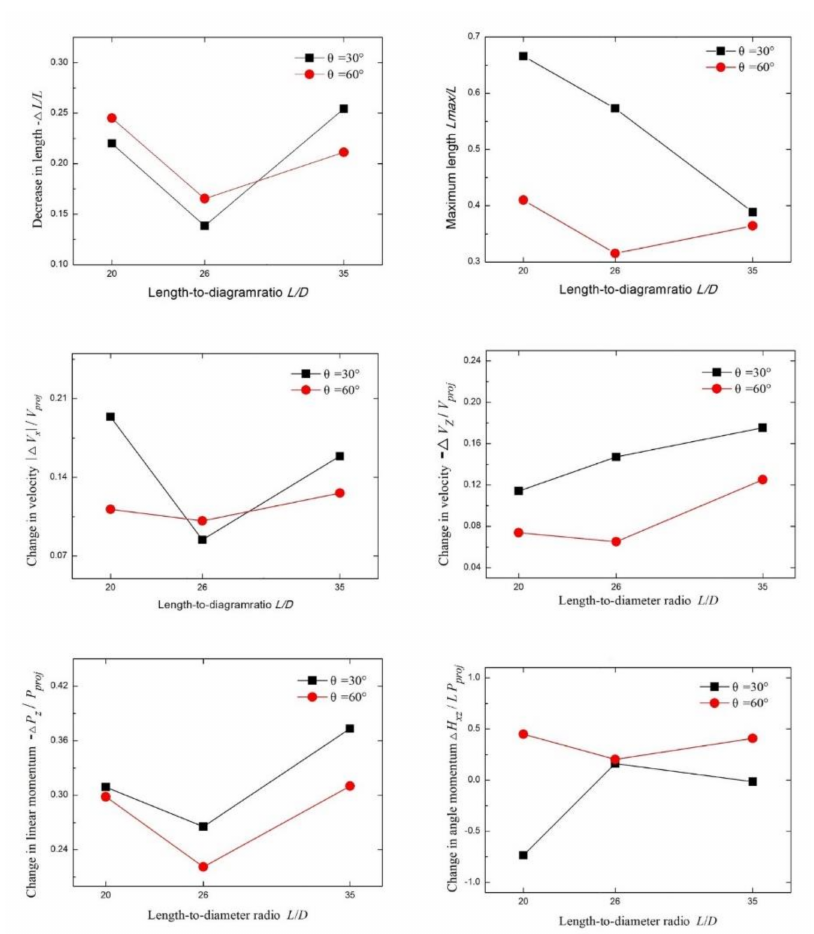
Figure 13. Influence of length to diameter ratio L / D of the long rod at di ff erent inclination angles. V x is the velocity component in the x-axis direction when the fractured rod is deflected by the LEFP. V x depends on the length of the fractured rod and the position of the fractured rod impacted by LEFP. The longer the length of the fractured rod, the larger the inertia and the smaller the V x . The rotation angle of the fractured rod depends on the position of fractured rod impacted by LEFP, implying that the positive and negative values of V x are di ff erent. | ∆ V x | is the absolute value of the velocity change of all fractured rods. The larger the | ∆ V x | value, the greater the longitudinal velocity obtained by all fractured rods. The instability of fractured rods is positively correlated with the angle of the fractured rods from the original penetration direction. It can be seen that when L / D was 20 and 35, | ∆ V x |/ V proj was greater than that of L / D =